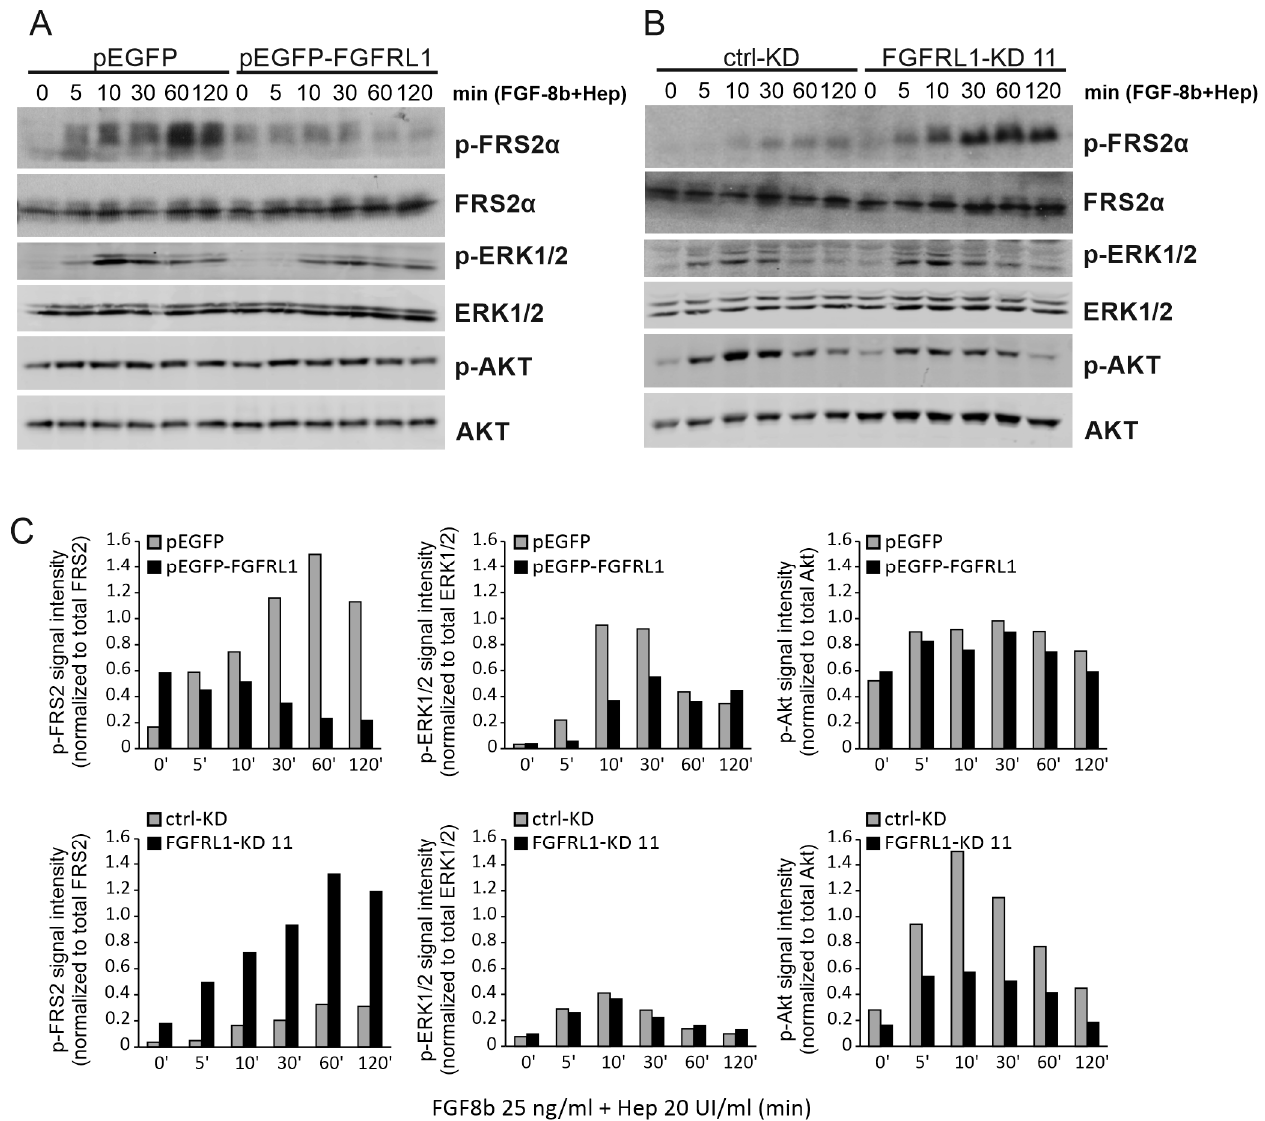
Figure 3. Western blot analysis of FGF-induced signaling in FGFRL1-modified tumor cells. ( A ) PC3M cells transfected with FGFRL1 overexpression (pEGFP-FGFRL1) or control vector (pEGFP). ( B ) sh-RNA transfected PC3M cells with stable FGFRL1 knockdown (FGFRL1-KD 11) and scrambled control (ctrl-KD). In both cases, serum-starved cells were treated with FGF-8b (25 ng/mL) and heparin (20 UI/mL) for indicated times. ( C ) Quantification of signal intensities of p-FRS2 α , p-ERK1/2, and p-Akt (Ser473) in Western blot. The phospho-protein intensity values were obtained using Image